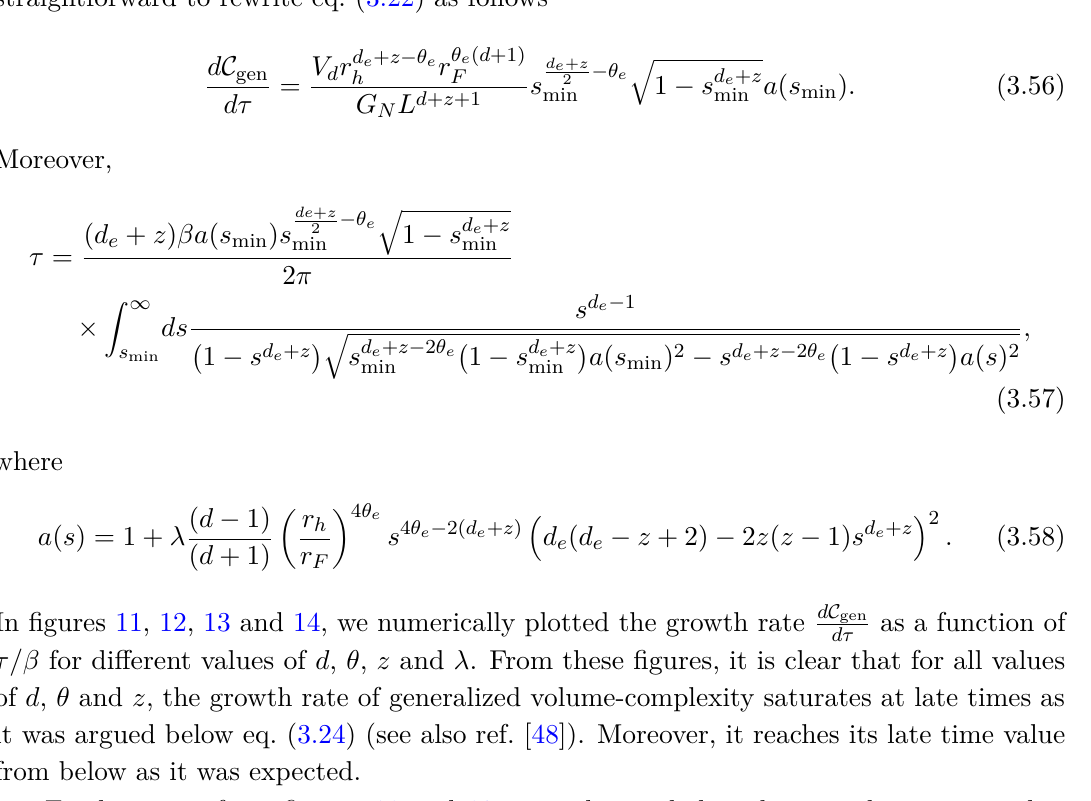
in eq. (3.22), as a function of τ/β for λ 6 = 0 and different values dτ , z = 3 . We set L = r 2 2